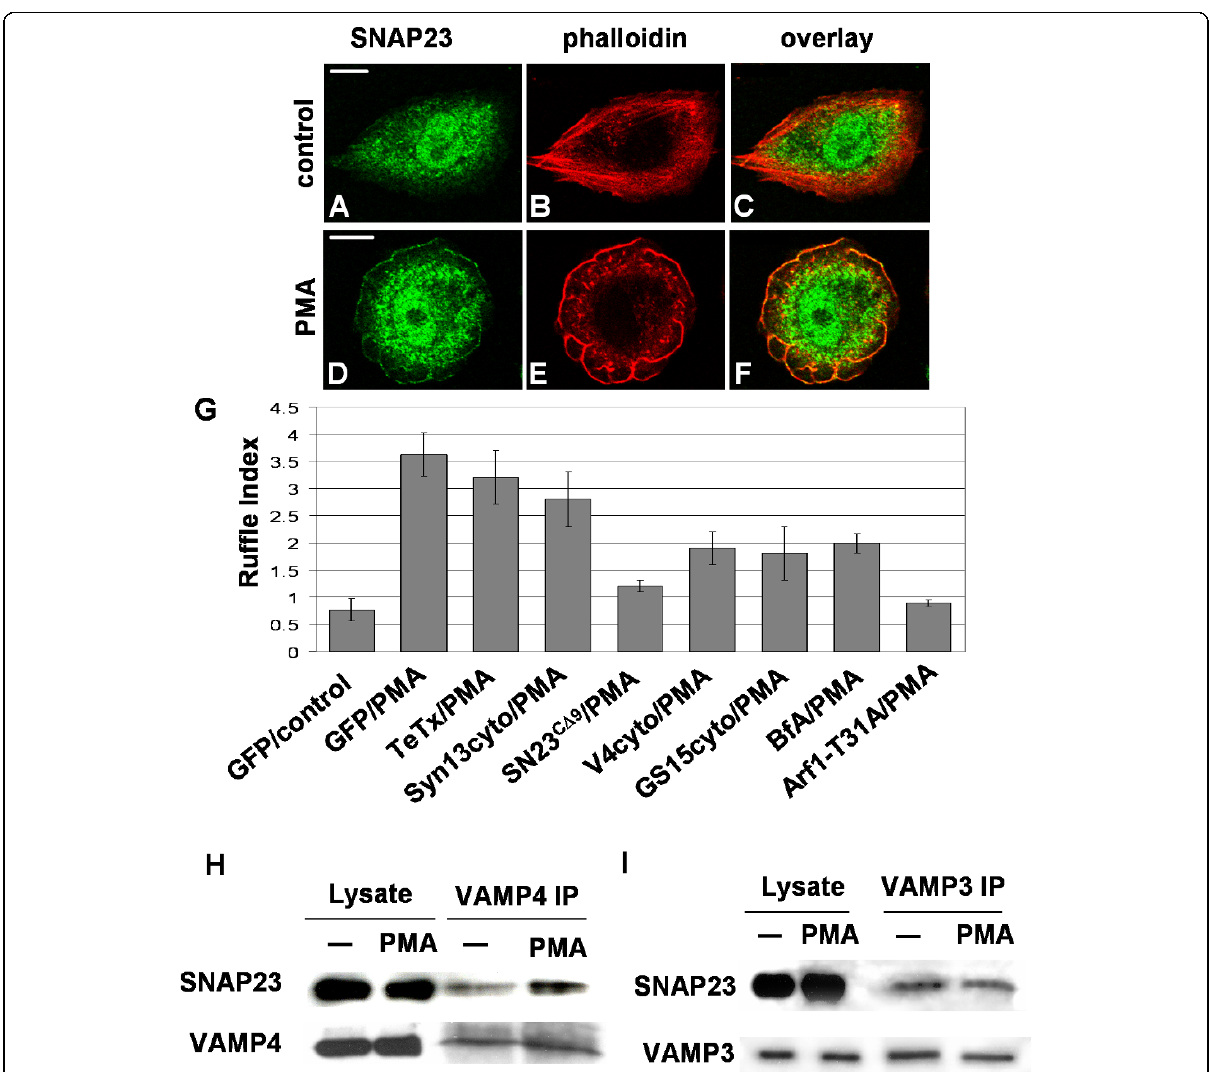
Figure 7 Analysis of SNARE function in PMA-induced membrane ruffle formation . CHO-K1 cells were treated with 500 nM PMA in DMEM (PMA) or DMEM alone (control) for 10 mins, fixed, permeabilized and stained with anti-SNAP23 antibody, Alexa-488-conjugated secondary antibody (A, D) and rhodamine-phalloidin (B, E). A-C, control cell; D-F, PMA-treated cell. Some cross-reactive binding of the SNAP23 antibody in the nucleus is observed (A, D). C and F are overlays of panels A and B and D and E, respectively. Scale bar represents 10 μ m. (G) CHO-K1 cells were transfected with GFP vector alone, GFP-tagged dominant-negative constructs of the indicated SNAREs, or GFP together with the light chain of tetanus toxin. HeLa cells were transfected for 72 h with GFP + PLOK-1 or GFP + vector containing SNAP23-targeting shRNA. Cells were treated with 500 nM PMA in DMEM (PMA) or DMEM alone (control) for 10 mins, fixed, permeabilized and stained with rhodamine-phalloidin. Samples were then imaged by confocal microscopy and actin-rich ruffles on the dorsal region of the cells were quantified as described previously. Ruffle indices (expressed as mean +/- SEM) are shown from three independent experiments (more than 25 randomly selected transfected cells were analyzed per condition in each experiment). (H and I) CHO-K1 cells were treated as above, lysed, and VAMP4 (H) or VAMP3 (I) were immunoprecipitated. Immunoprecipitates were washed and analyzed by SDS-PAGE-western blotting for SNAP23, upper blots . Then membranes were stripped and reprobed for the precipitated SNARE, lower blots